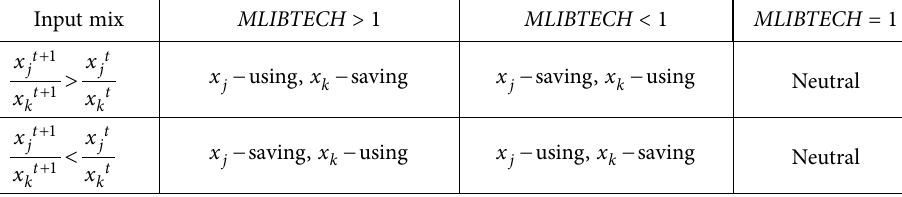
Table 1. Changes in the input mix and input biased technological